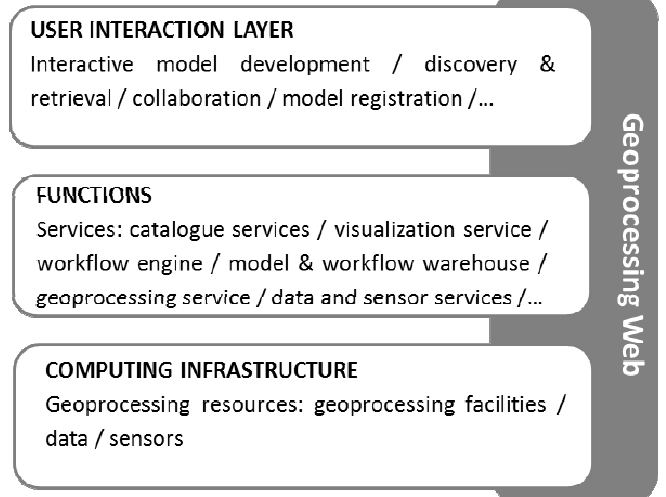
Figure 4. Key components of the geoprocessing after Zhao et al .